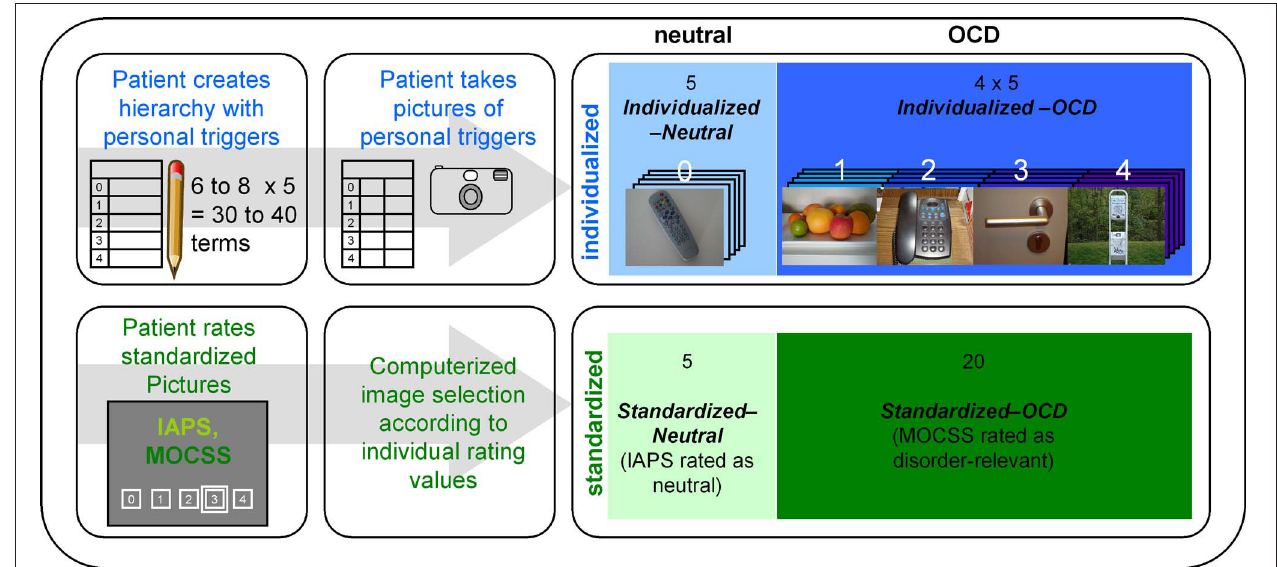
shades represent higher stimulus intensities. The photographs depicted here are pictures taken by a participant of the OCD group (written informed consent for publication has been obtained). The white numbers above the photographs represent the stimulus intensity (the hierarchy level) of each picture. “Computerized image selection” refers to the image selection process described in the Stimuli and Design